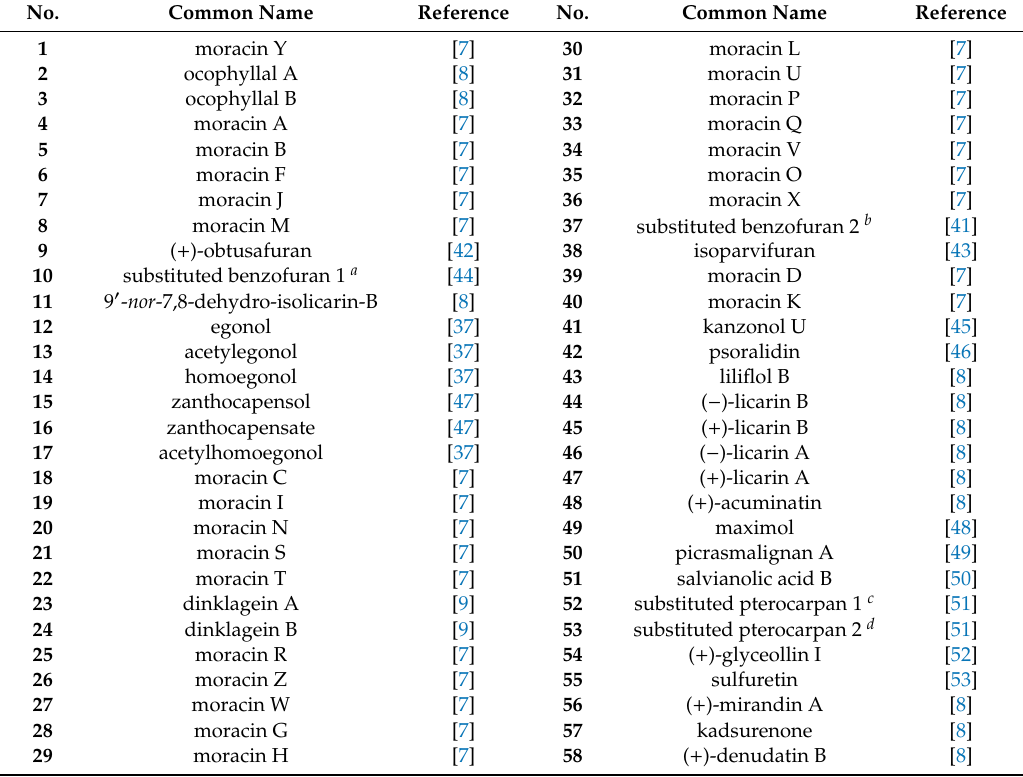
Table A1. Common names of test 2-arylbenzofuran-related compounds.